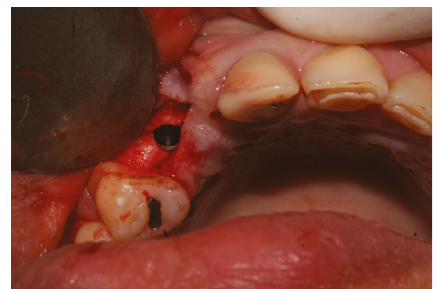
Figure 4: Installation of the new implant.